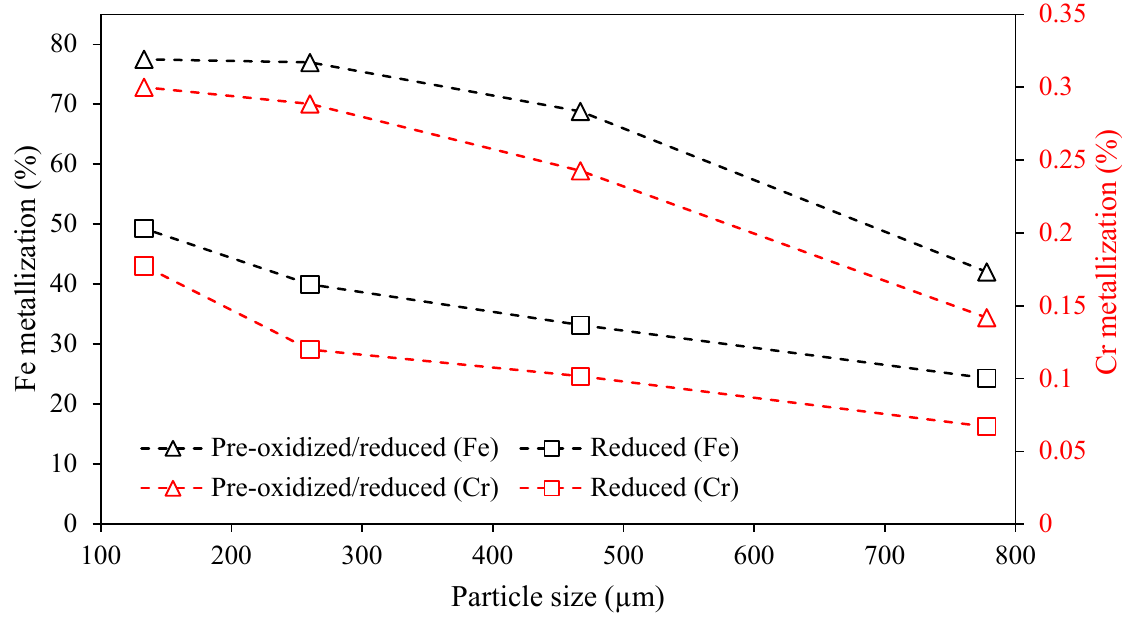
Figure 8. The effects of pre-oxidation (1100 °C for 60 min) on the Fe and Cr metallization of samples reduced at 1100 °C for 60 min at a hydrogen flow rate of 750 mL/min.